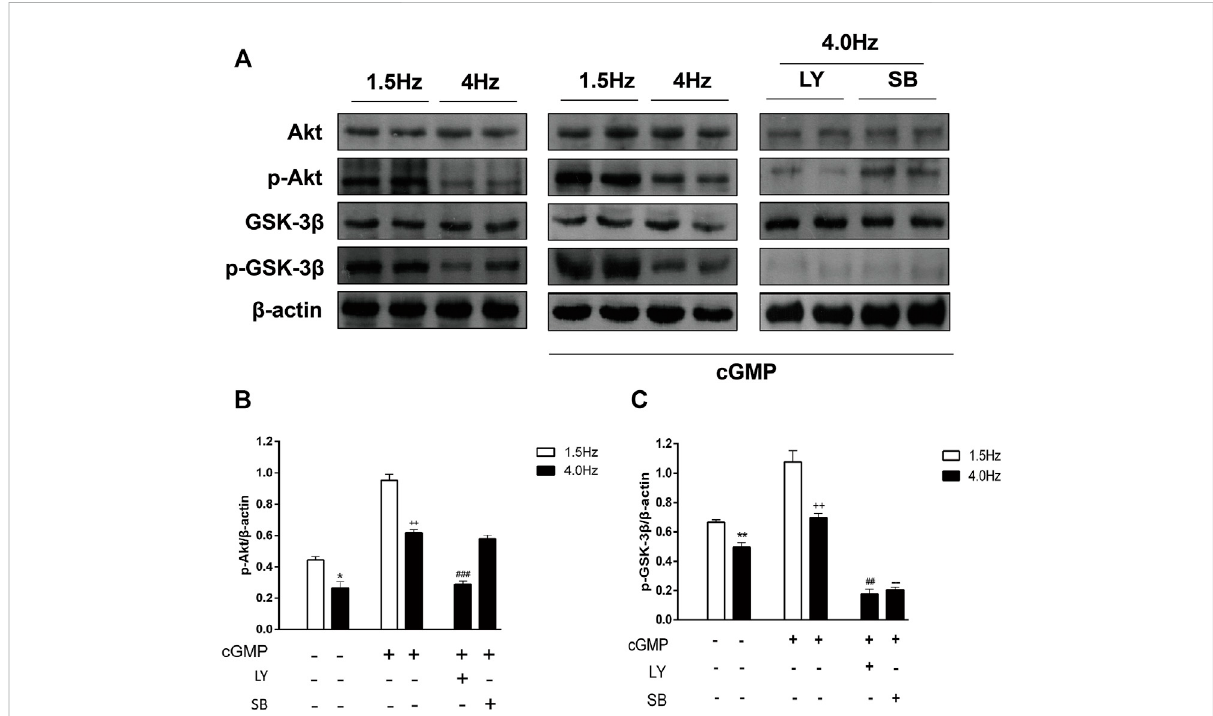
FIGURE 11 Effects of high-frequency stimulation on the cGMP/Akt/GSK-3 β signaling pathway. (A) Effects of high-frequency stimulation, cGMP, and inhibitors on theAkt, p-Akt, GSK-3 β , and p-GSK-3 β protein levels were detected byWesternblotting. (B) Quantitative analysis ofp-Aktproteinlevels byfollowinghigh-frequency stimulation, cGMP treatment, andinhibitortreatment.* p < 0.05vs.1.5 Hz; ++ p < 0.01 vs.4.0 Hz; ### p < 0.001 vs.4.0 Hz + cGMP. (C) Quantitative analysis of p-GSK-3 β protein levels following high-frequency stimulation, cGMP treatment, and inhibitor